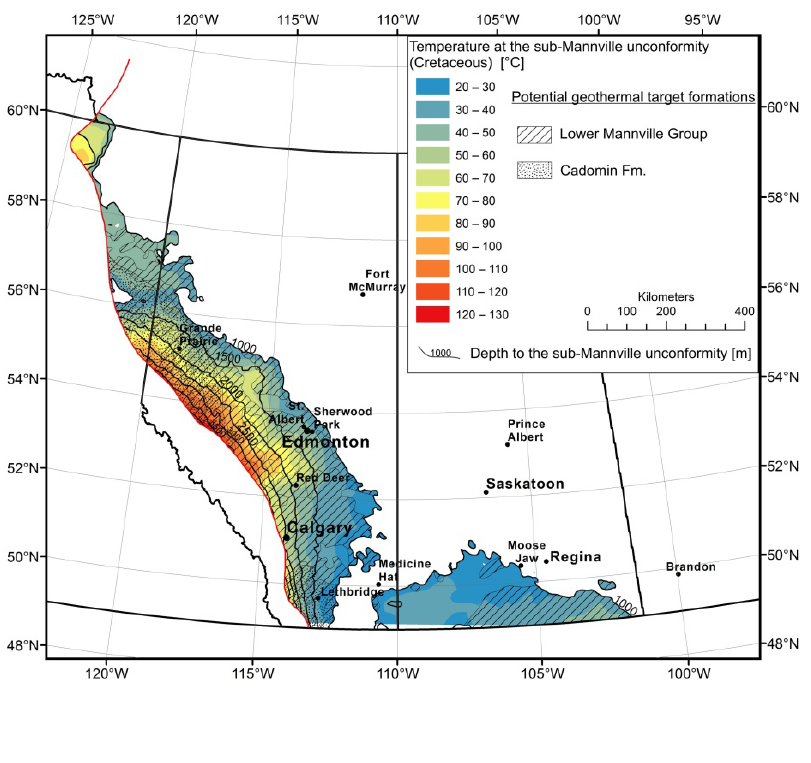
Figure 9. Temperature at the sub-Mannville unconformity; formations outline from Hayes et al.